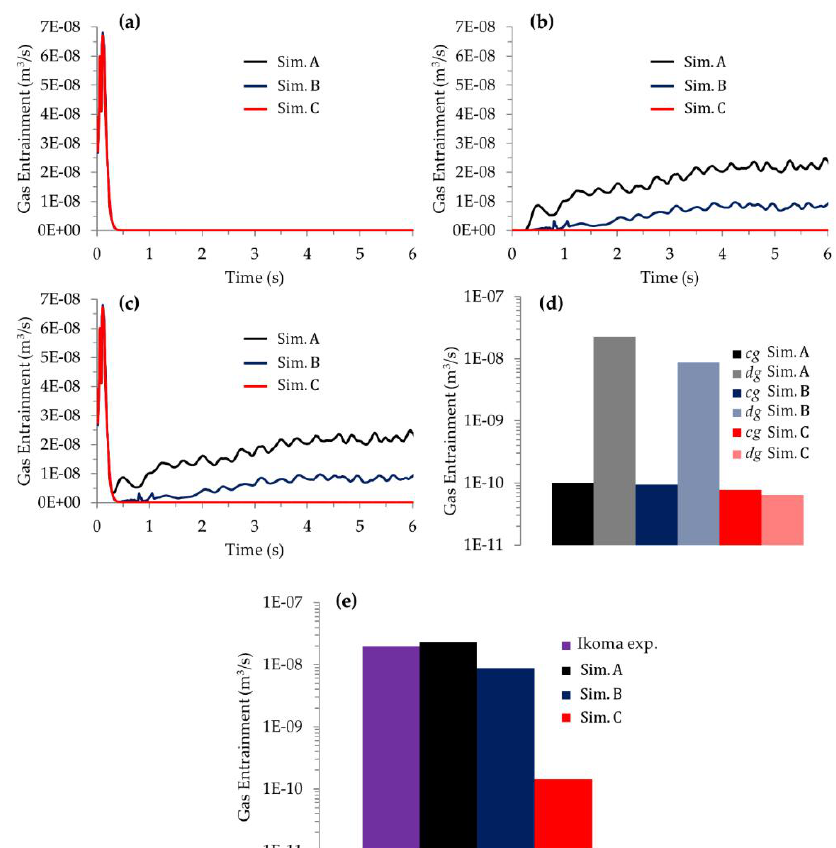
Figure 8. Transient profile of gas entrainment rate of: ( a ) potentially continuous gas, ( b ) dispersed gas, and ( c ) total gas. Average gas entrainment rate of: ( d ) cg and dg and ( e ) total. The results are obtained from the simulations using C ent = 2 × 10 − 4 . The experimental gas entrainment rate is based on [71,72].